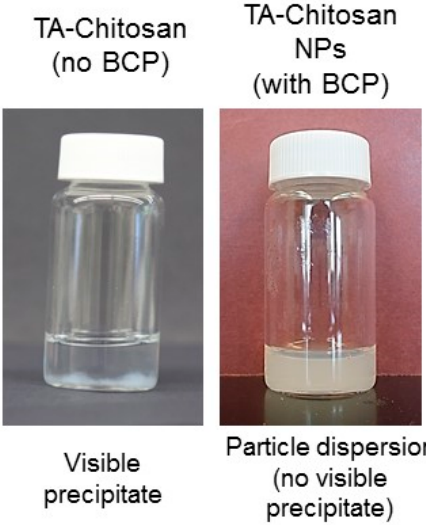
Figure 2. Macroscopic (visible) precipitates form upon mixing tannic acid (TA) and chitosan without including a block copolymer (BCP) stabilizer (left). In contrast, a particle dispersion with no visible precipitate was achieved in the presence of the BCP stabilizer to prevent precipitation of the TA-chitosan complex.